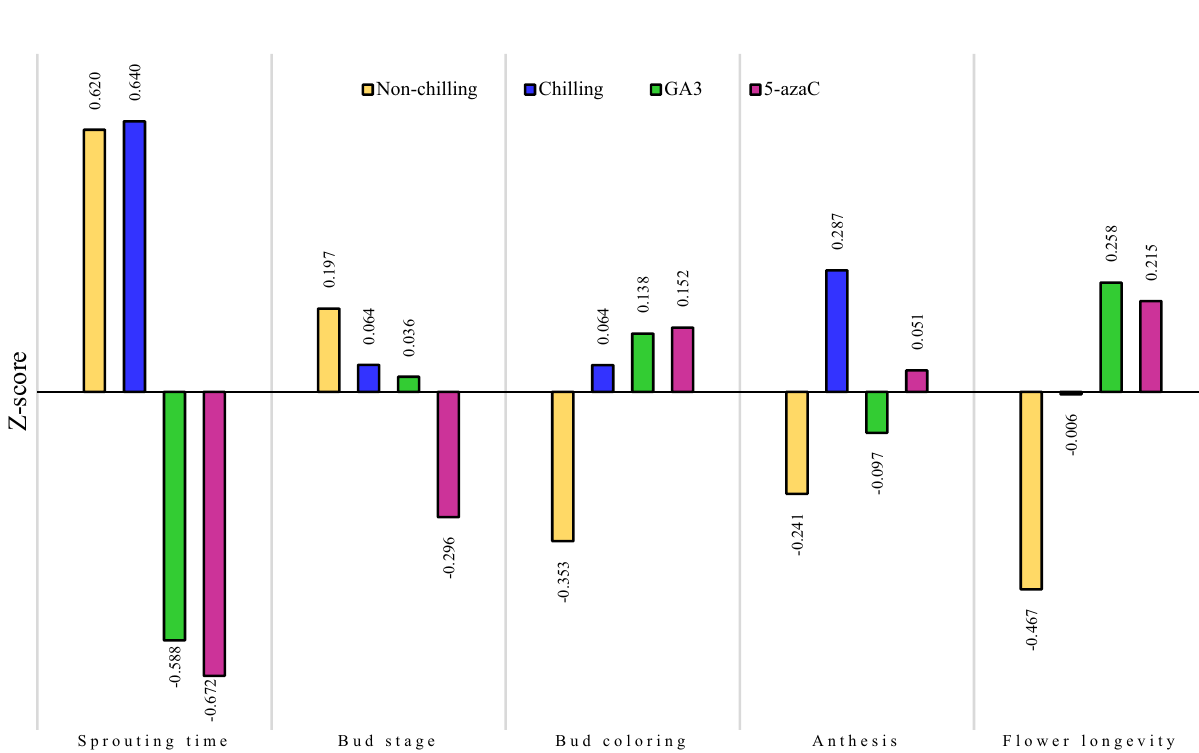
Figure 1. Distribution of the values of the Z-scores for phenological traits under different pre-treatment conditions in 18 studied accessions of Anemone . Z-score was calculated as the difference between the mean of the trait (for each pre-treatment) and the total mean, divided by the total standard deviation (SD). The highest negative Z-scores are associated with the relative lowest value of the variable among the conditions. Since the decrease in the value of phenological traits (except for flower longevity on plant) is a desirable feature, the pre-treatments with more negative Z-scores were considered as more favorable for increasing the rate of plant